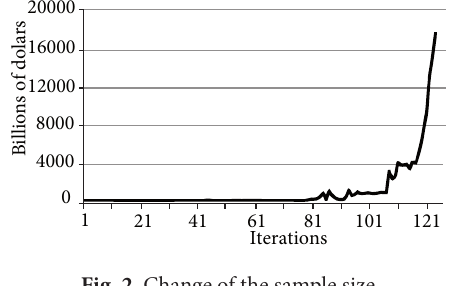
Fig. 1. Change of the objective function Fig. 2. Change of the sample size